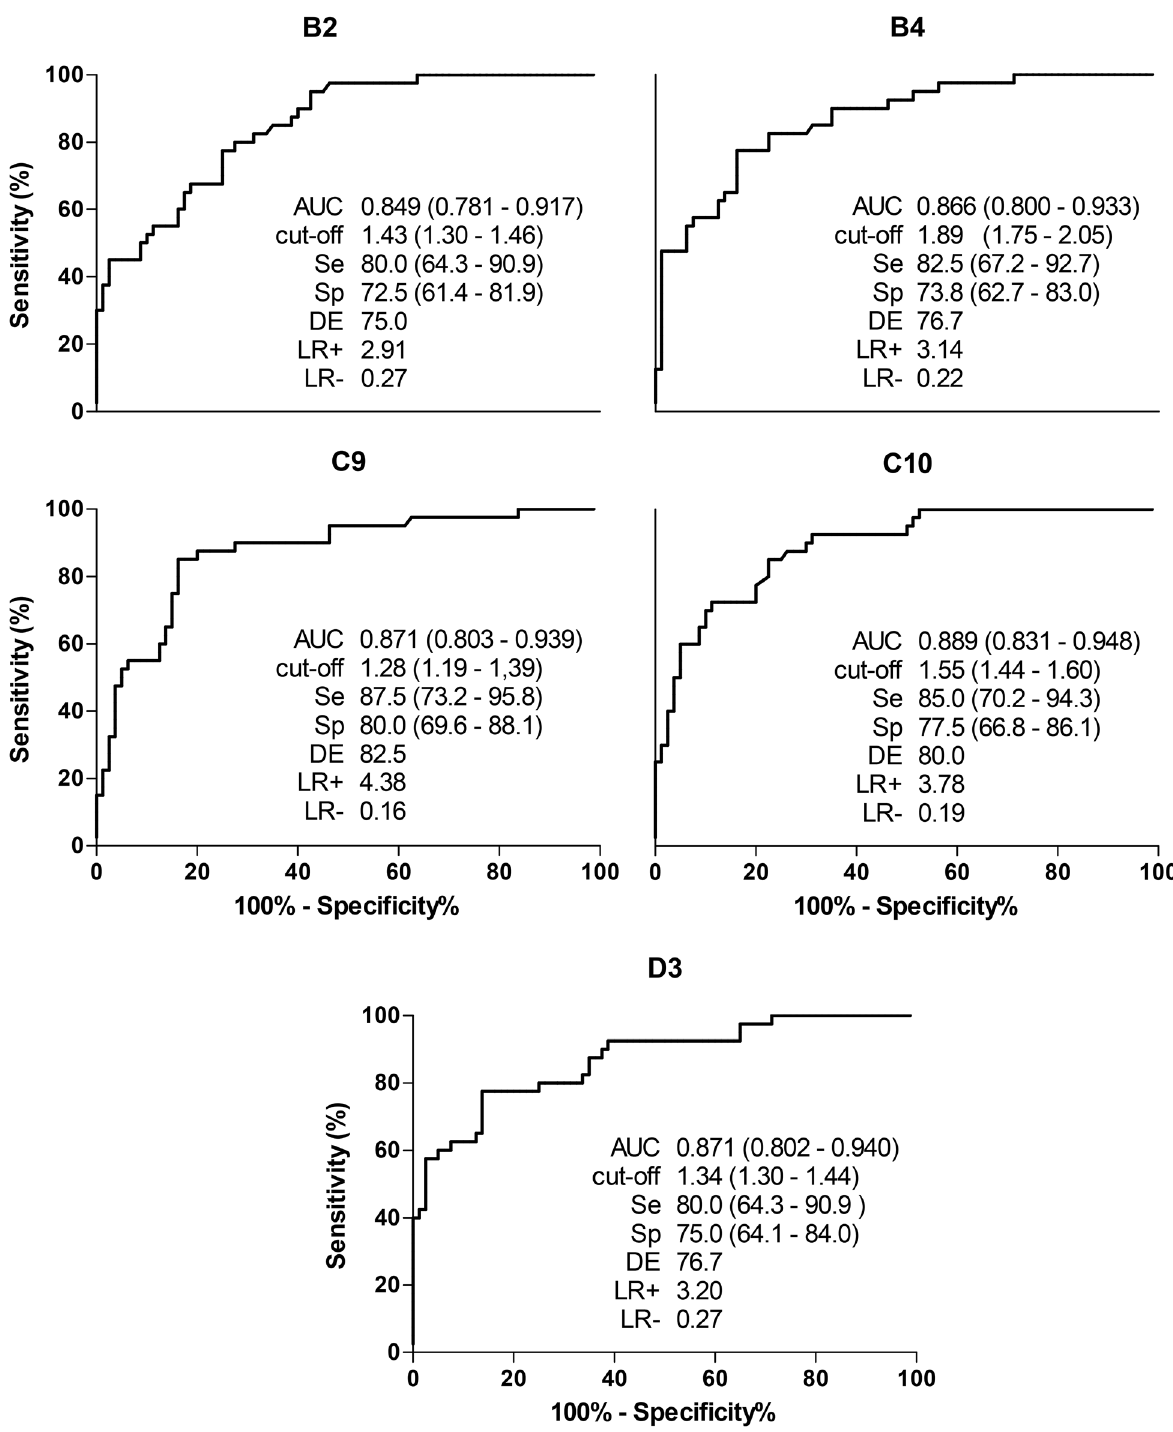
Figure 2. ROC curve analyses of IgG detection in serum samples using phage-clones. The figure shows AUC (area under curve), cut-off, sensitivity (Se), specificity (Sp), diagnostic efficiency (DE) and LR (likelihood ratios) in the optimum point of reaction for the phage clones B2, B4, C9, C10 and D3. (95% confidence interval). doi:10.1371/journal.pntd.0002792.g002 venezuelensis has been used as an alternative, due to antigenic ties to obtain sufficient quantities of Strongyloides larvae used in antigenic preparations and also due to cross-reactivity with other similarity with S. stercoralis [18,47], and because it does not present helminths. There are no commercial kits available with S. stercoralis a risk to human health and can be easily obtained in rats [5]. We recombinant antigens. Therefore, the heterologous antigen from S. have properly demonstrated the utility of S. venezuelensis in